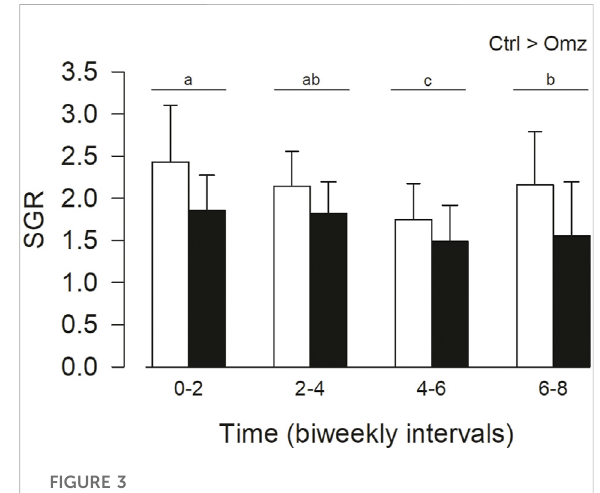
FIGURE 3 Nile tilapia ( Oreochromis niloticus ) growth trial. PIT tagged Nile tilapia were fed daily a 2% BM ration of pellets that were either sham treated (Control; Ctrl, white bars) or dosed with omeprazole at 25 mg kg − 1 BM (Omeprazole; solid bars) over an eight- week period and weighed every 2 weeks. Speci fi c growth rates (SGR) were calculated over bi-weekly intervals. Data was analyzed by two-way ANOVA with SNK post hoc test; n = 23. There were signi fi cant treatment (Ctrl > Omz) and time effects but without interactions. The time intervals with unshared letters are signi fi cantly different from each